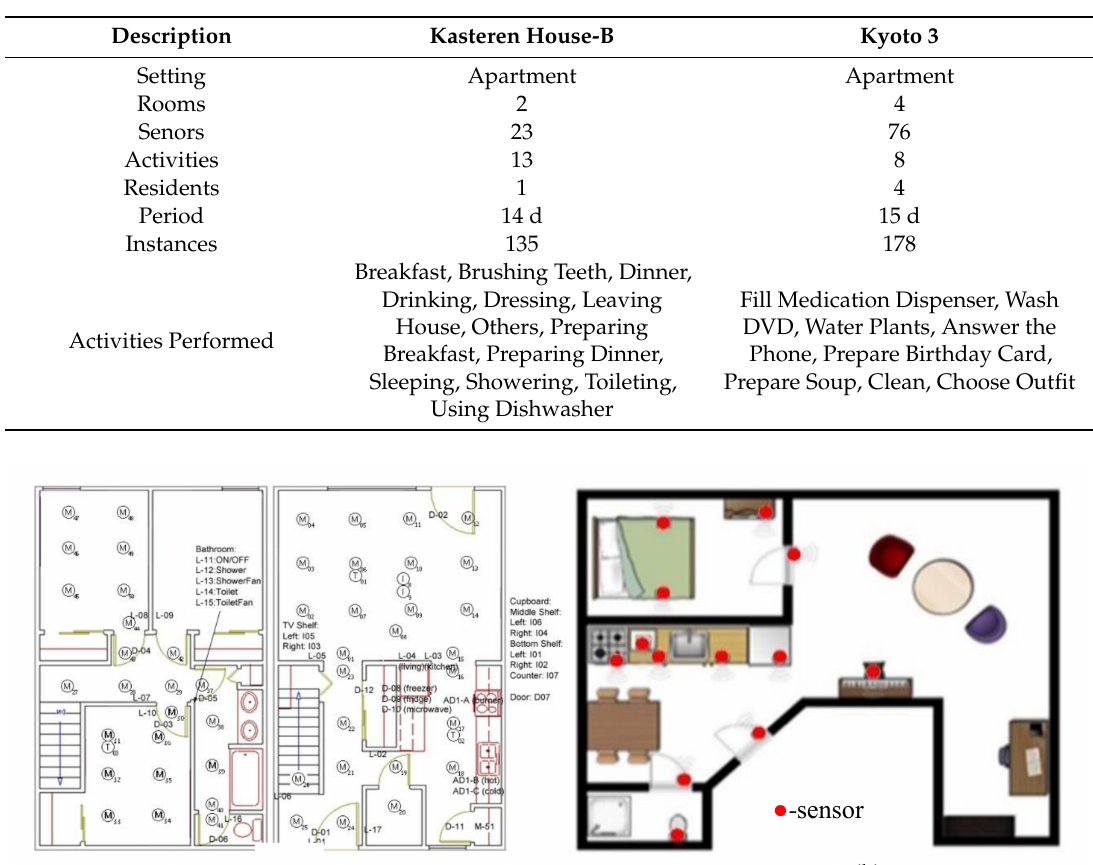
Table 1. Overview of datasets used in the evaluation of the proposed method.